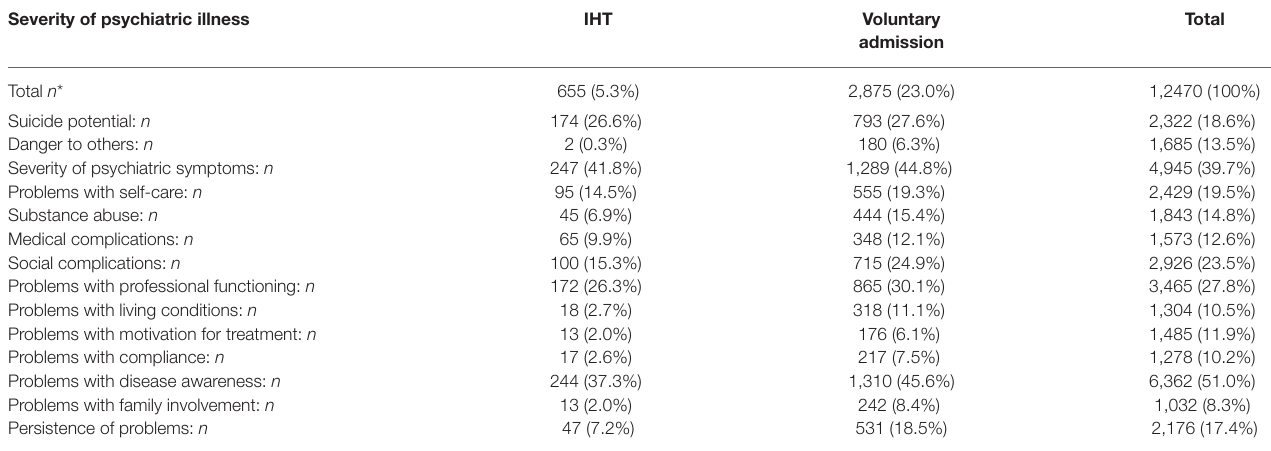
TABLE 2 | SPI of patients assessed by the psychiatric emergency services. Severity of psychiatric